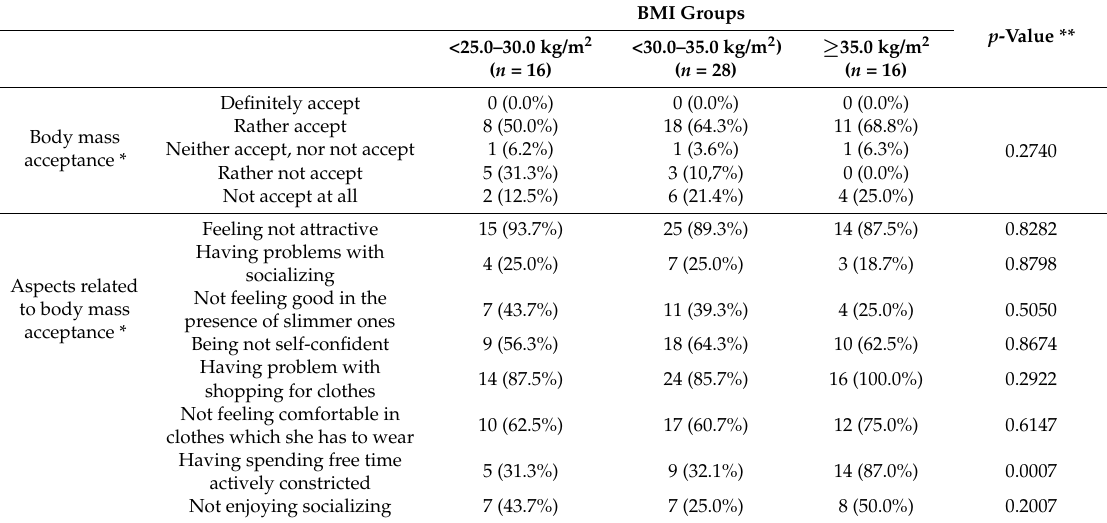
Table 4. The body mass acceptance of the studied group for the sub-groups stratified by